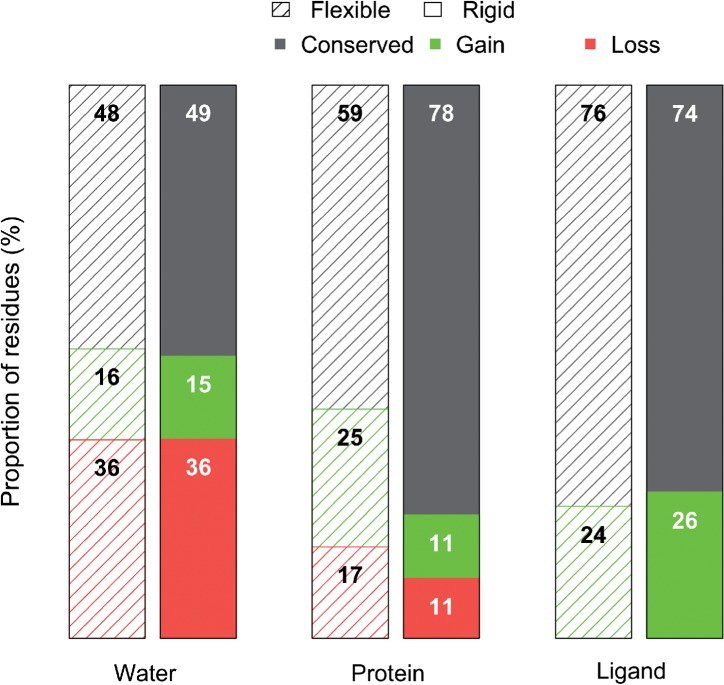
Rearrangement of the Hydrogen bonding network. We plot the proportion of residues that conserve the number, gain or loose H-bonds with water molecules, protein or ligand atoms. We observe a 36% decrease in the number of H-bonds between binding-site residues and water molecules with a concomitant increase of the number of H-bonds for with protein atoms for flexible residues (center left), likely formed with rigid residues as these conserve the number of H-bonds in 80% (center right) of cases. Interestingly, ~75% of residues that could form H-bonds with the ligand upon binding do not fulfill these interactions (right-hand bars)